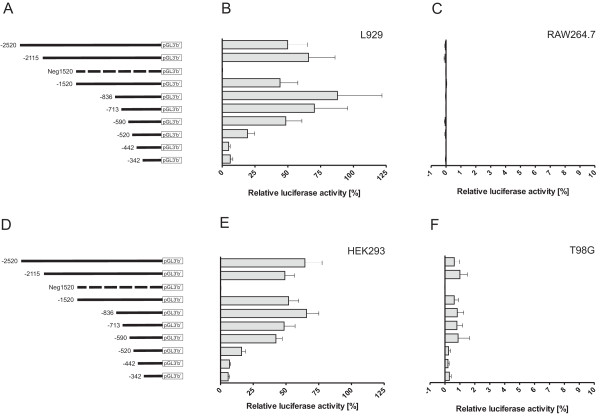
Reporter assays with different fibin promoter lengths. (A, D) Various lengths of human genomic sequences upstream of the fibin translation start were amplified and cloned into a pGL3 vector. Murine (B) L929 cells and (C) RAW264.7 cells as well as human (E) HEK293 cells and (F) T98G cells were transfected with the various promoter constructs. RAW264.7 cells and T98G cells served as the respective mouse and human negative controls because no endogenous fibin-mRNA expression was found (see Figure 2C). Luciferase activity was measured 48 h later and normalized to luciferase activity driven by an SV40 promoter with average values of 2,483 cps (L929 cells), 21,975 cps (HEK293), 12,896,311 cps (RAW264.7 cells), and 147,769 cps (T98G cells). Data are given as mean ± SEM of four to seven independent experiments.